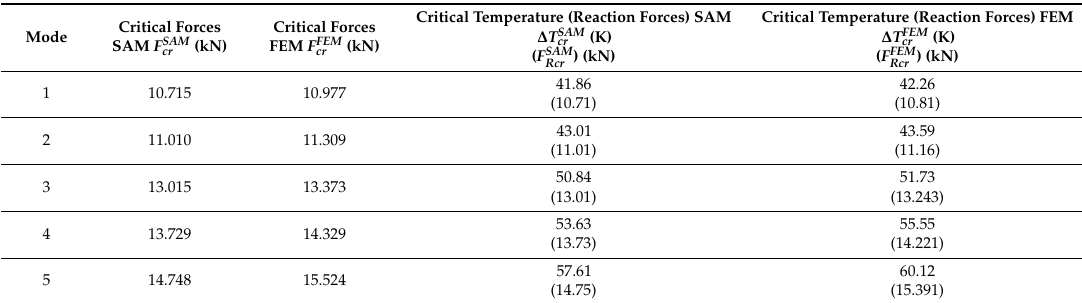
Table 2. The critical loads obtained by using two